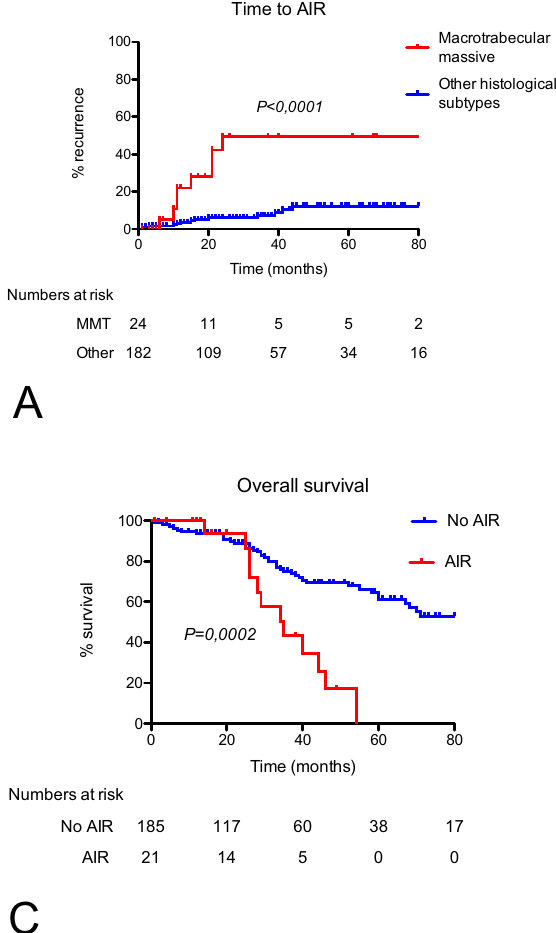
Figure 4. Time to aggressive intrasegmental recurrence according to radiological and histological features and overall survival according to the presence of aggressive intrasegmental recurrence. Kaplan–Meier curves for AIR according to the macrotrabecular massive subtype at histology ( A ), and non smooth tumor margin at imaging ( B ). Kaplan–Meier curves for survival according to the occurrence of an aggressive intrasegmental recurrence ( C ). Statistical analysis was performed using the log rank test. The numbers at risk were reported under the x axis. The cox-proportional hazard assumption is fulfilled in the